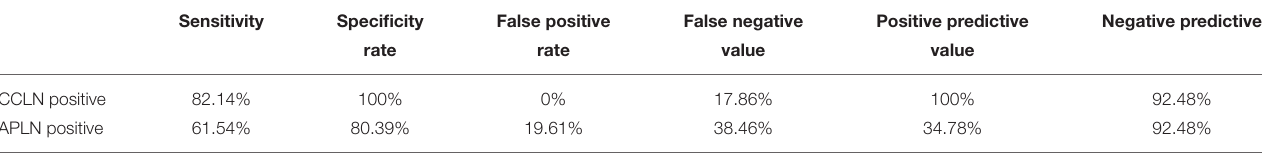
TABLE 5 | Predictive value of SLN for CCLN and APLN metastasis.